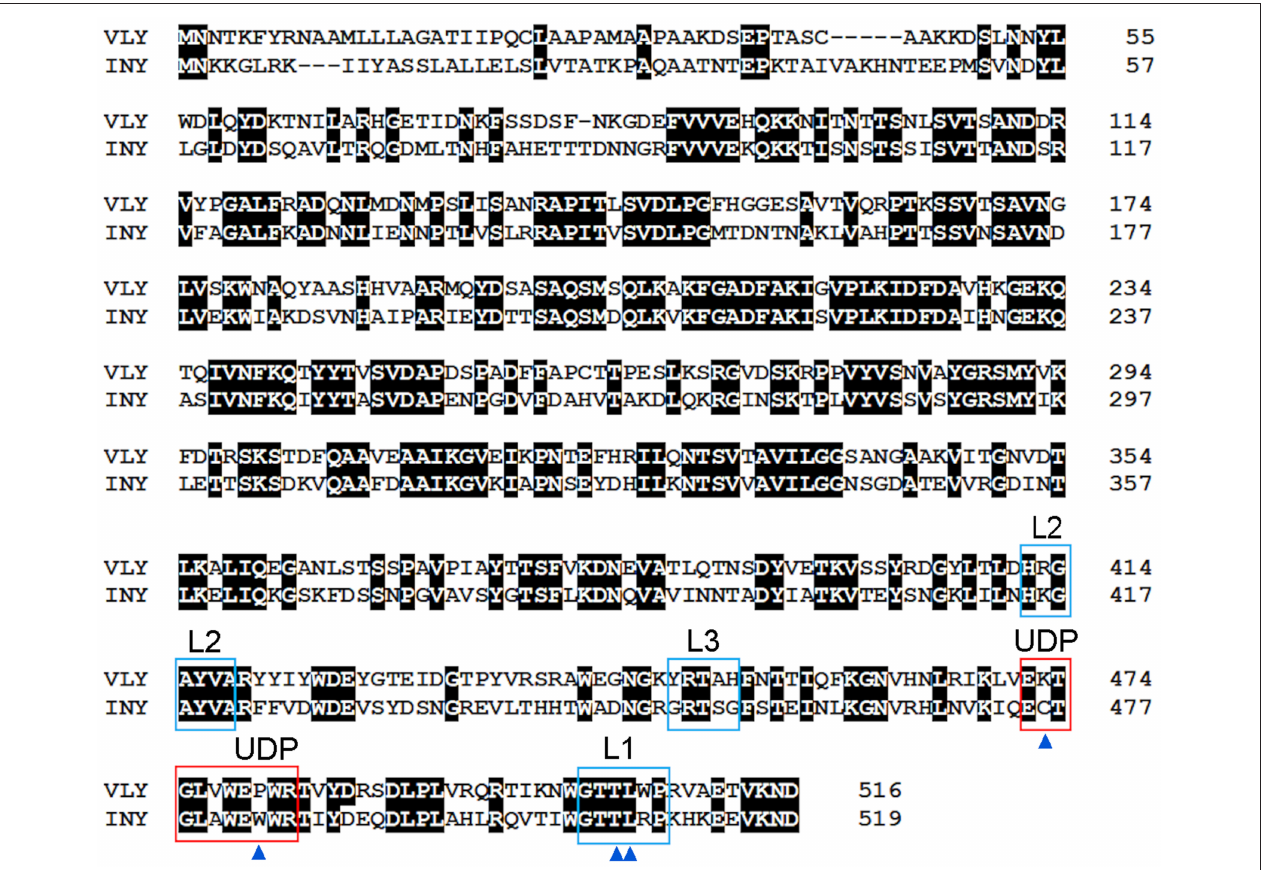
FIGURE 2 | Amino acid sequence alignment of VLY (accession no. ACD63042) and INY (accession no. WP_006730404). The sequences were aligned using Clustal W ( Aiyar, 2000). Strictly conserved residues are indicated with a black background. Loops L1–L3 and the undecapeptide (UDP) are framed in blue and red, respectively. Cys residue in UDP of INY, the Pro/Trp in UDP, and the Thr-Leu pair (CMR) in L1 are indicated by blue